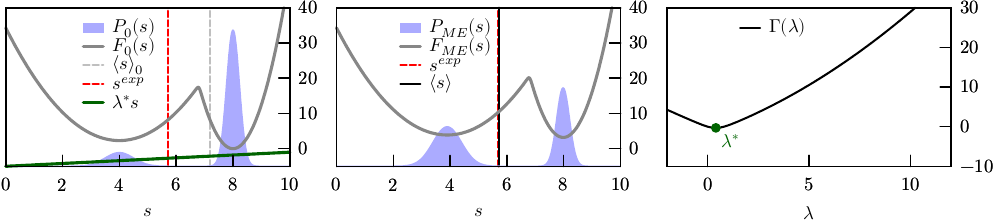
Figure 1. The effect of a linear correcting potential on a given reference potential. P 0 ( s ) is the marginal probability distribution of some observable s ( q ) according to the reference potential V 0 ( q ) and F 0 ( s ) is the corresponding free-energy profile ( left panel ). Energy scale is reported in the vertical axis and is given in units of k B T . Probability scales are not reported. Vertical lines represent the average value of the observable s in the prior ( (cid:104) s (cid:105) 0 ) and in the experiment ( s exp ). A correcting potential linear in s (green line) shifts the relative depths of the two free-energy minima, leading to a new free energy profile F ME ( s ) = F 0 ( s ) + k B T λ ∗ s that corresponds to a probability distribution P ME ( s ) ( central panel ). Choosing λ ∗ equal to the value that minimizes Γ ( λ ) ( right panel ) leads to an average (cid:104) s (cid:105) = s exp . Any experimental data that is the result of an ensemble measurement can be used as a